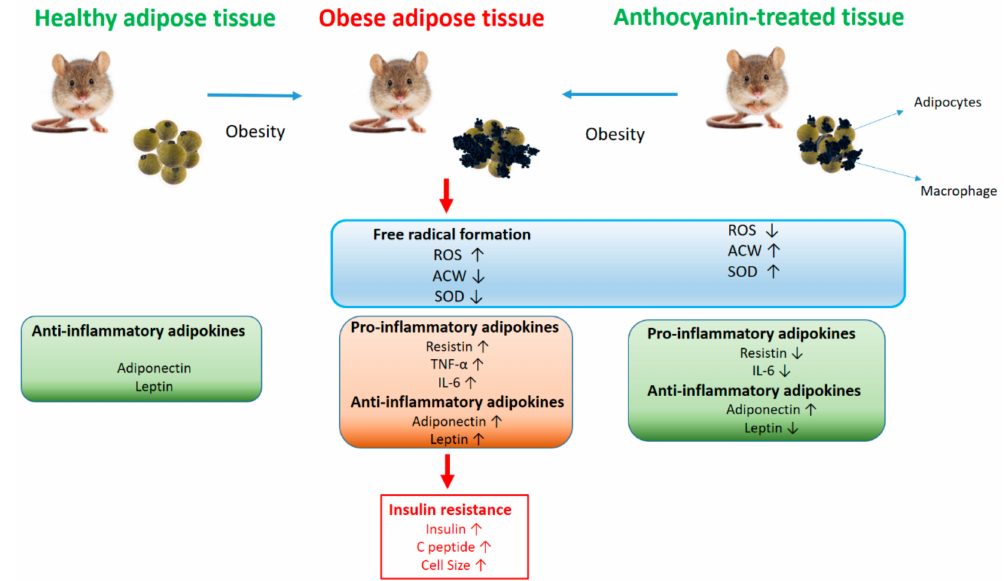
Figure 9. Overview of the results. Graphical interpretation of the result show the modification of the followed main investigations: oxidative stress parameters, cytokines, and adipokines in healthy, obese, and obese anthocyanin treated animal